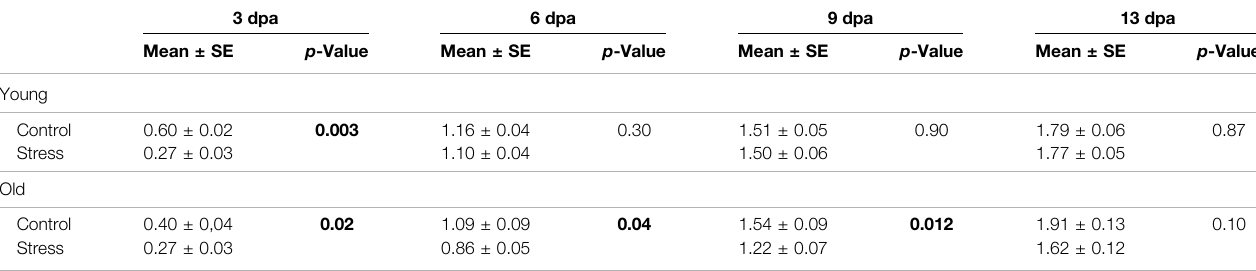
TABLE 2 | Caudal fi n growth measurements after amputation for young and old zebra fi sh.